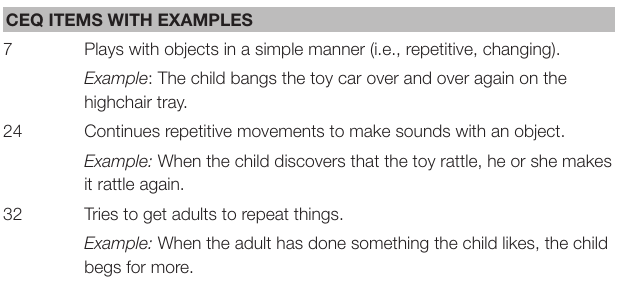
TABLE 1 | Excluded original CEQ items (De Kruif and McWilliam, 1999). CEQ ITEMS WITH